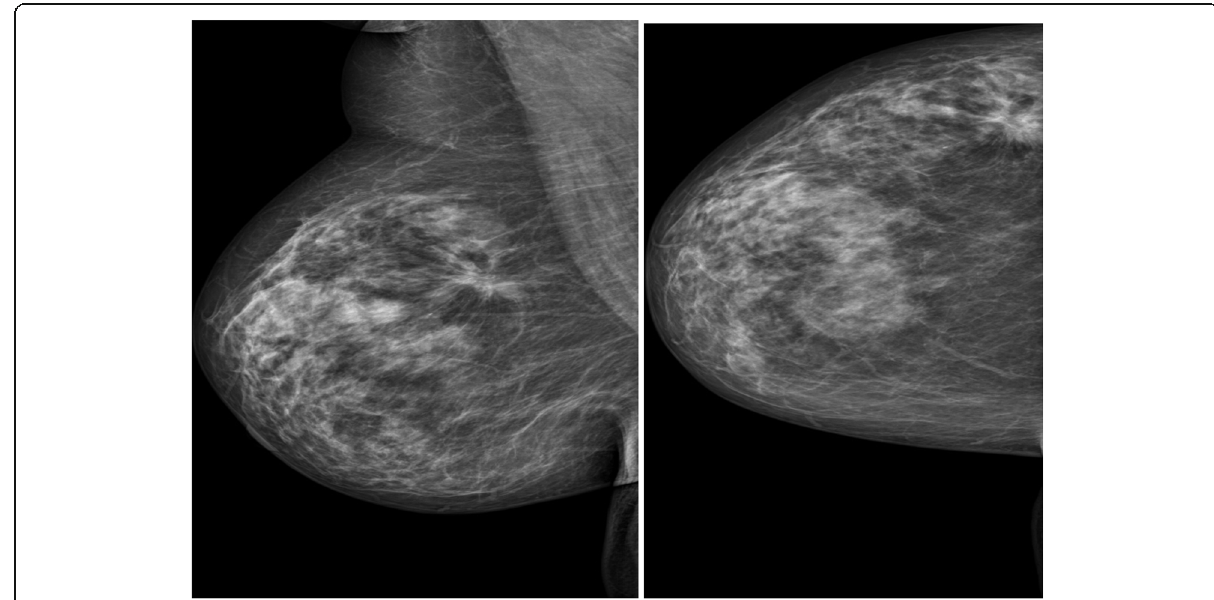
Fig. 3 Sixty-year-old female for screening ACR C. Right UOQ irregular shape speculated outline dense